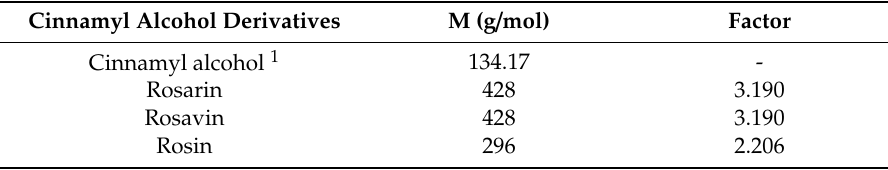
Table 3. Correction factors for quantification of cinnamyl alcohol derivatives relative to reference standard.